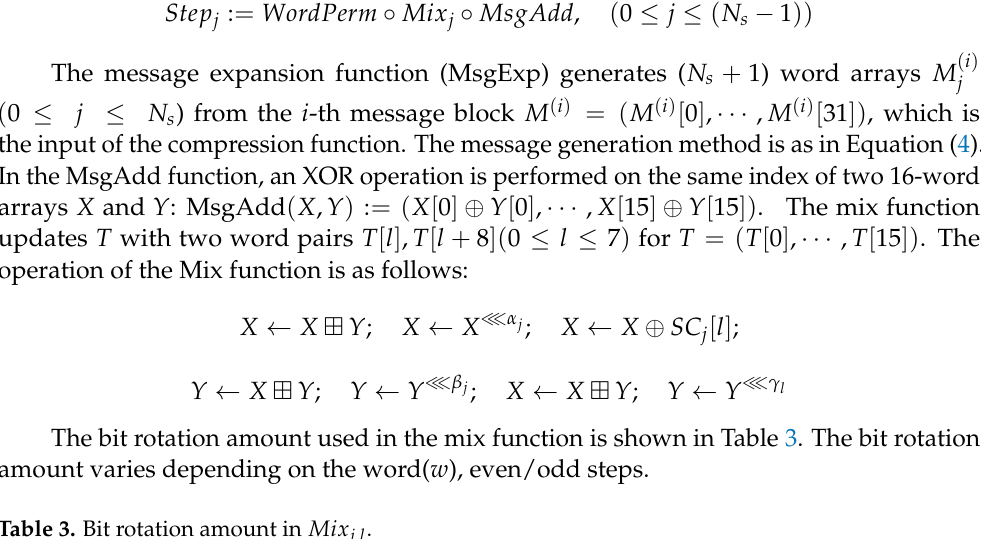
Table 3. Bit rotation amount in Mix j , l